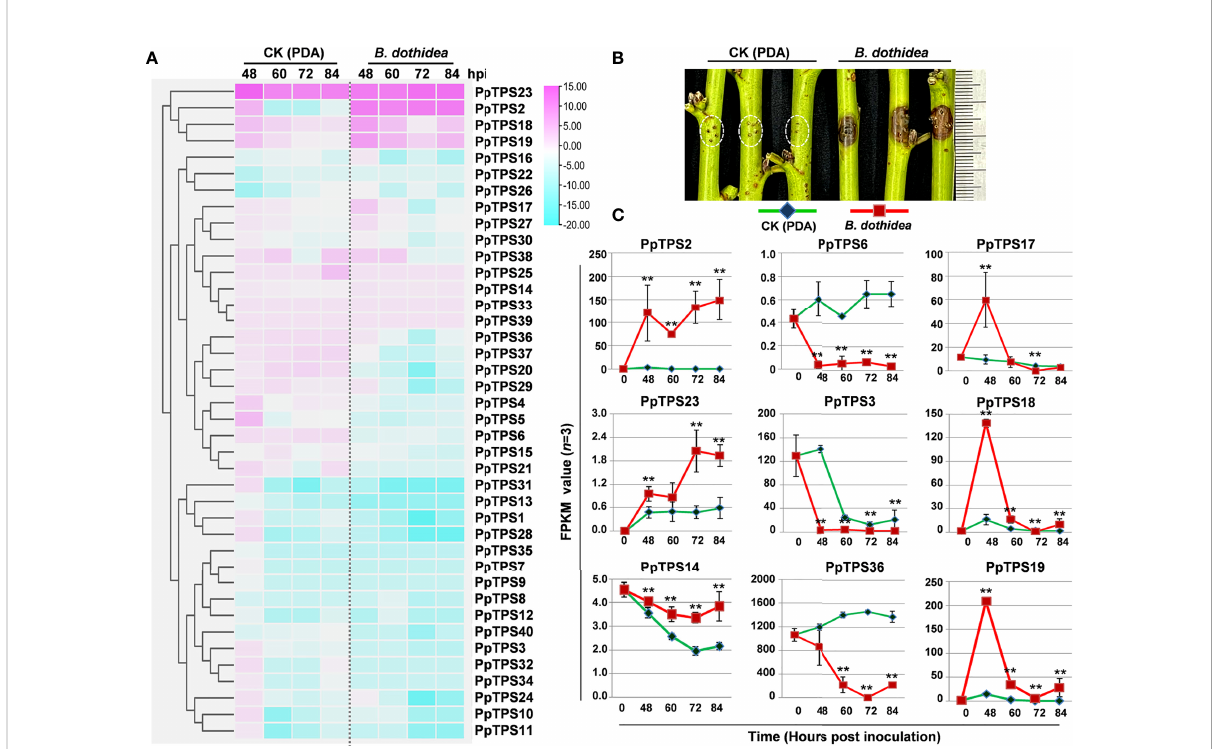
FIGURE 3 Expression pro fi les of PpTPS genes in peach shoots post B. dothidea inoculations determined by RNA sequencing. (A) A heatmap shows the relative transcript levels (FPKM value) of forty PpTPS genes in the shoots of ‘ Huyou018 ’ after PDA medium (Mock) and B. dothidea inoculations. The color scale represents log(fold change, 2) values of PpTPSs transcript levels at each time point (48 h, 60 h, 72 h, and 84) compared with 0 h after each treatment, with pink denoting increased transcript abundance and blue denoting decreased transcript abundance. (B) The representative photograph shows the phenotype of peach shoots at 48 h after B. dothidea inoculations. (C) Line graphs show the detailed FPKM value of nine selected PpTPS genes after PDA medium (Mock) and B . dothidea inoculations. The asterisks denote that the FPKM values of a gene in B . dothidea inoculations were signi fi cantly different with that in Mock ( p <0.05). The detailed FPKM values of PpTPSs in pathogen inoculation assays were presented in Supplementary Table